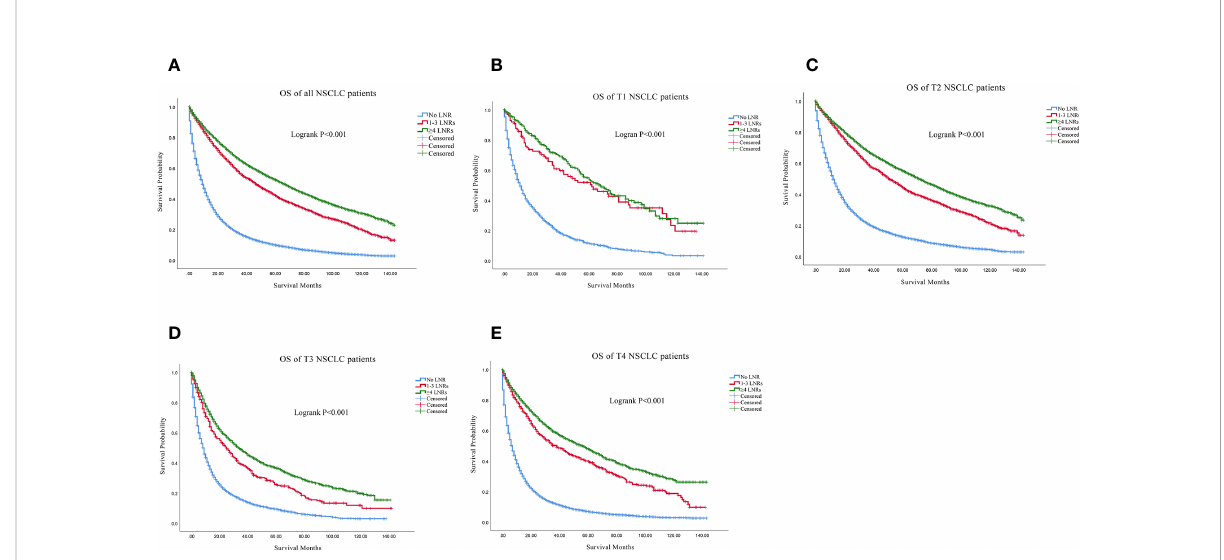
FIGURE 2 Comparison of OS in no LNR group, 1-3 LNR group and ≥ 4 LNRs group for N0 NSCLC patients. (A) Comparison in all the N0 NSCLC patients; (B) Comparison in T1 N0 NSCLC patients; (C) Comparison in T2 N0 NSCLC patients; (D) Comparison in T3 N0 NSCLC patients; (E) Comparison